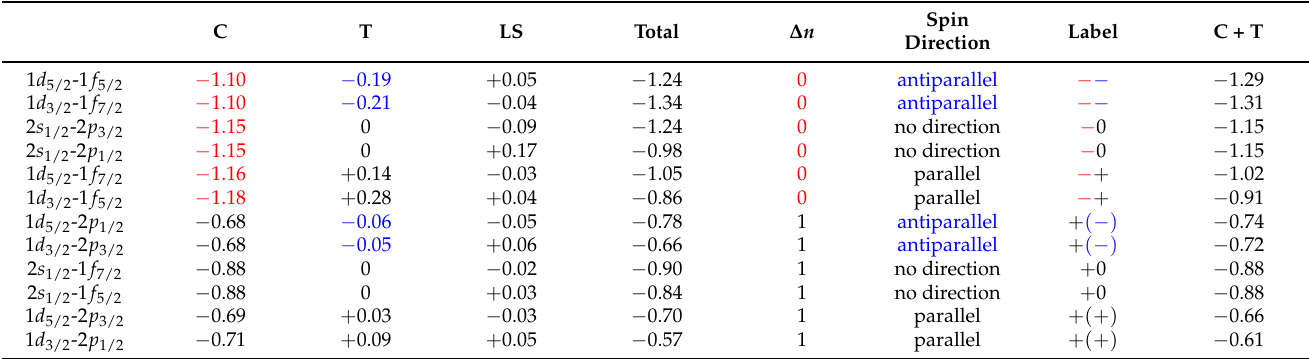
Table 1. Proton–neutron monopole matrix elements between the sd and pf orbitals obtained by the SDPF-MU interaction for the atomic mass number A = 42. The second to the fifth columns list the central (C), tensor (T), spin–orbit (LS), and the total values (in MeV), respectively. The sixth to ninth columns indicate the hierarchy of the C + T monopole matrix elements. The texts in red (blue) are to highlight the correspondence between the most attractive matrix elements of the central (tensor) force and ∆ n = 0 (spin direction). See text for